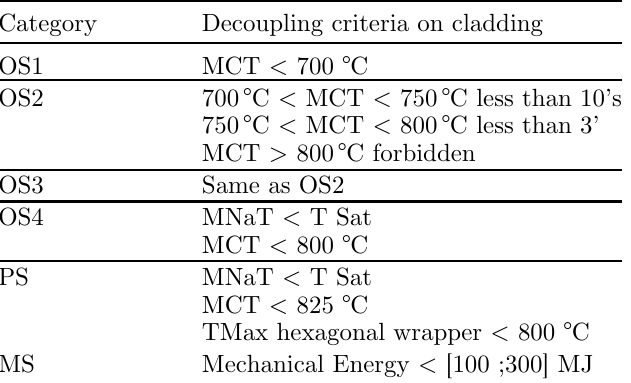
Table 2. Decoupling criteria resulting from general safety